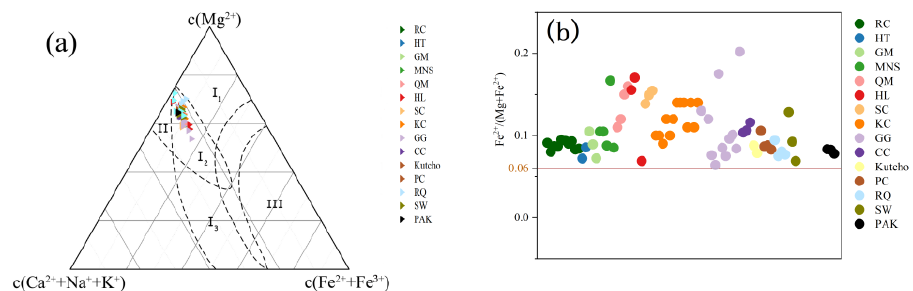
Figure 10. ( a ) Ternary plot of c(Mg), c(Ca + K + Na), and c(Fe 2+ + Fe 3+ ) in green nephrite from